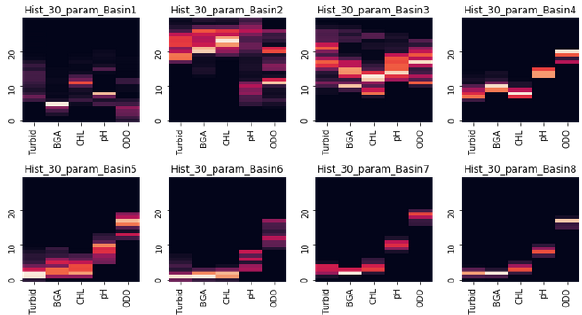
Figure 4. Parameter profiles of the basins